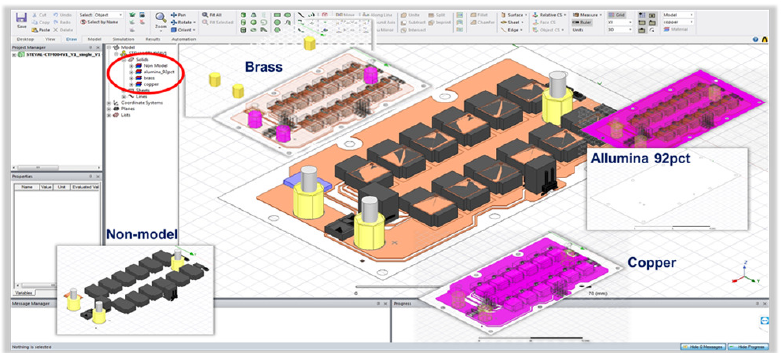
Figure 6. Complete assignment of the materials.